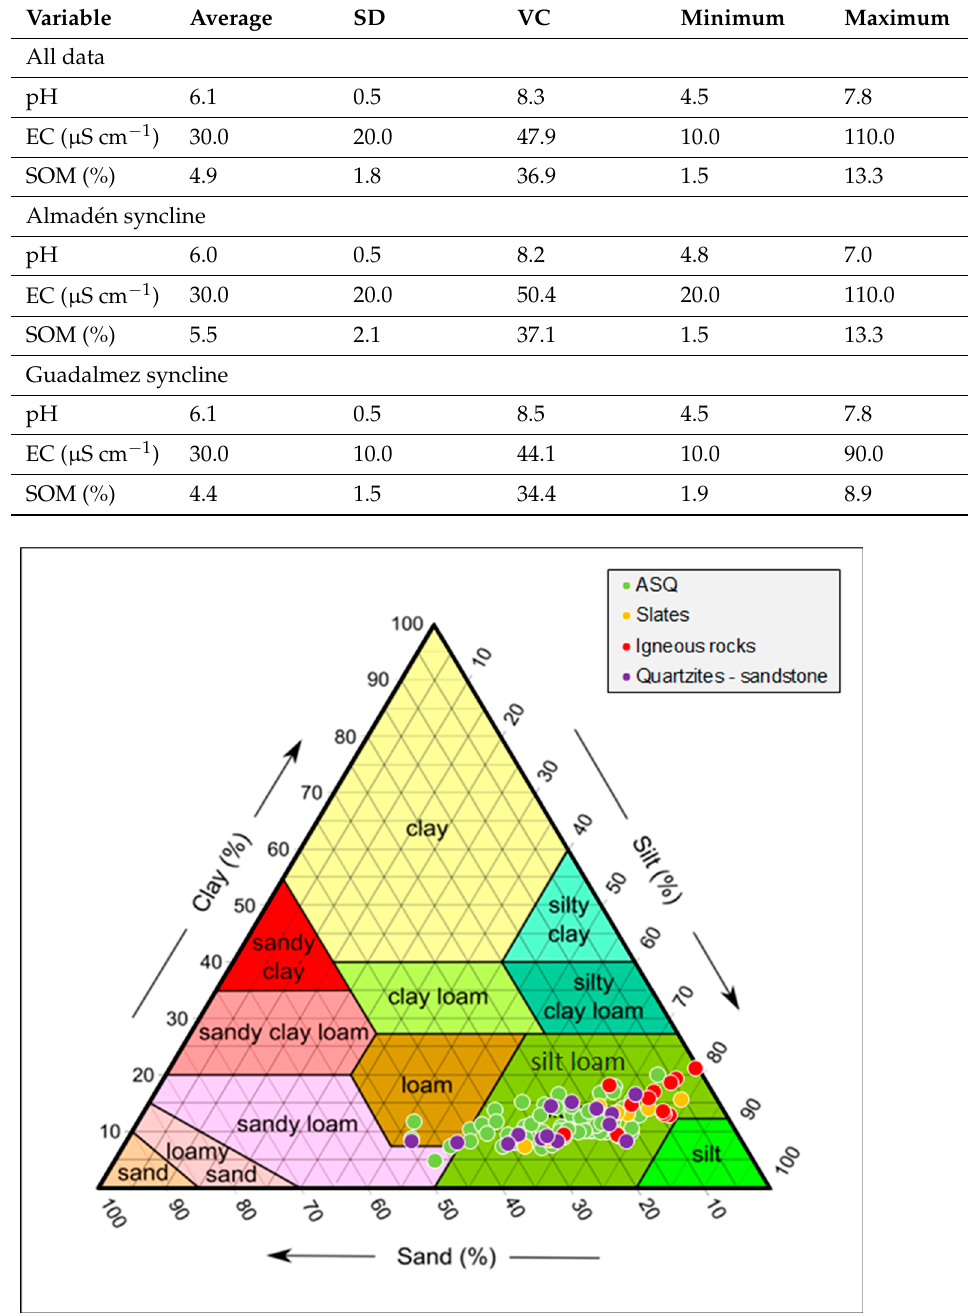
Figure 2. Texture of samples. ASQ: alternations of shales and quartzites.